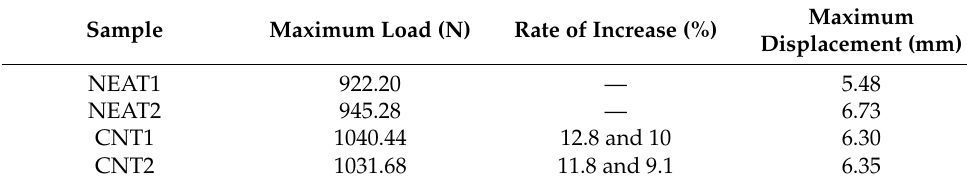
Table 7. The buckling load and vertical displacements of clamped–clamped supported